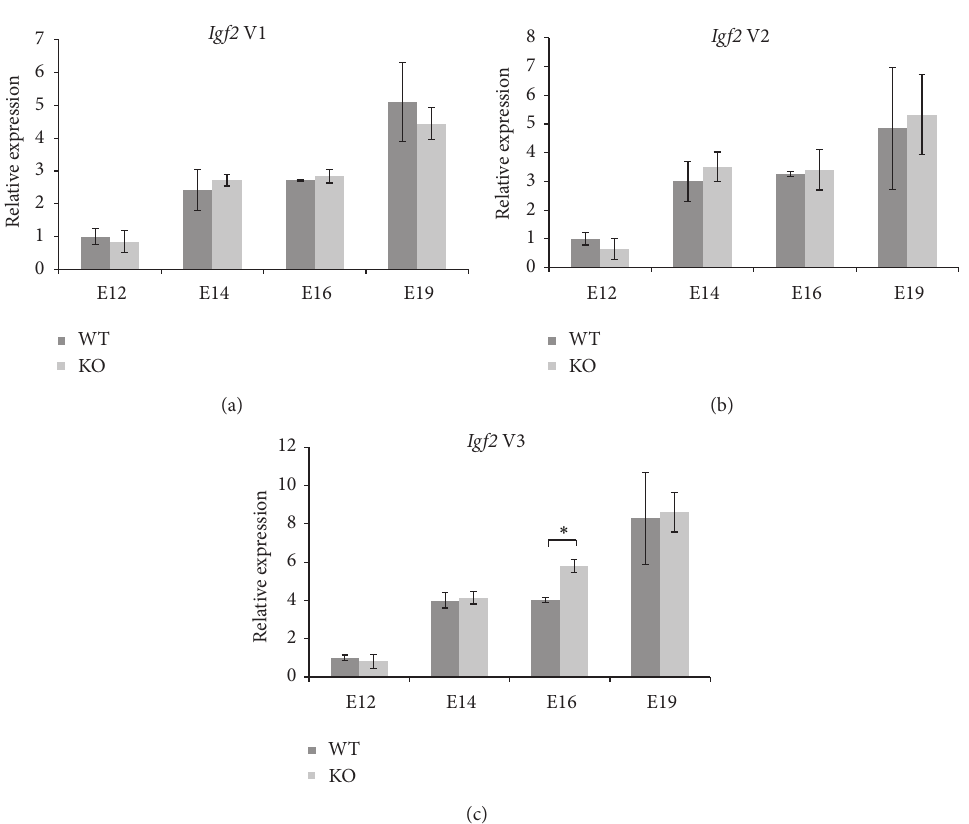
Figure 4: Quantification of Igf2 variants expression levels in wild-type and Δ DMR1-U2 knockout placenta. Quantification of Igf2 transcripts performed in wild-type (WT) and knockout (KO) placentas at different embryonic stages (E12, E14, E16, and E19). Igf2 variants 1 (a), 2 (b), and 3 (c) were measured by qPCR. The results are expressed in relative expression. Each bar represents the mean of three samples each quantified in triplicate. The standard deviation is indicated by error bars. ∗ 𝑃 < 0.05 .